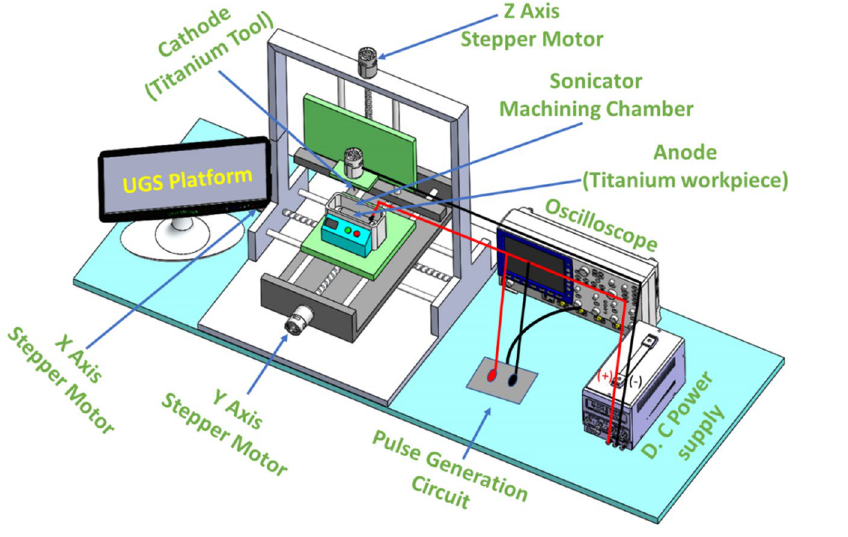
Figure 2. 3D schematic view of the developed ES-µ-ECDM experimental